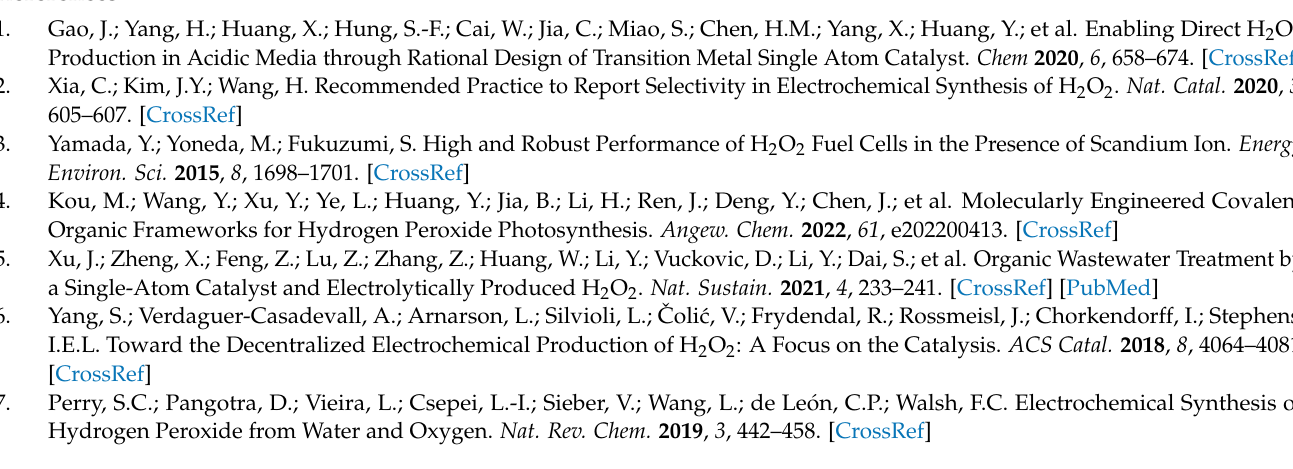
after a 5 times cycling test; Figure S7: (a) schematic diagram of the Ag@CNNS; (b) local